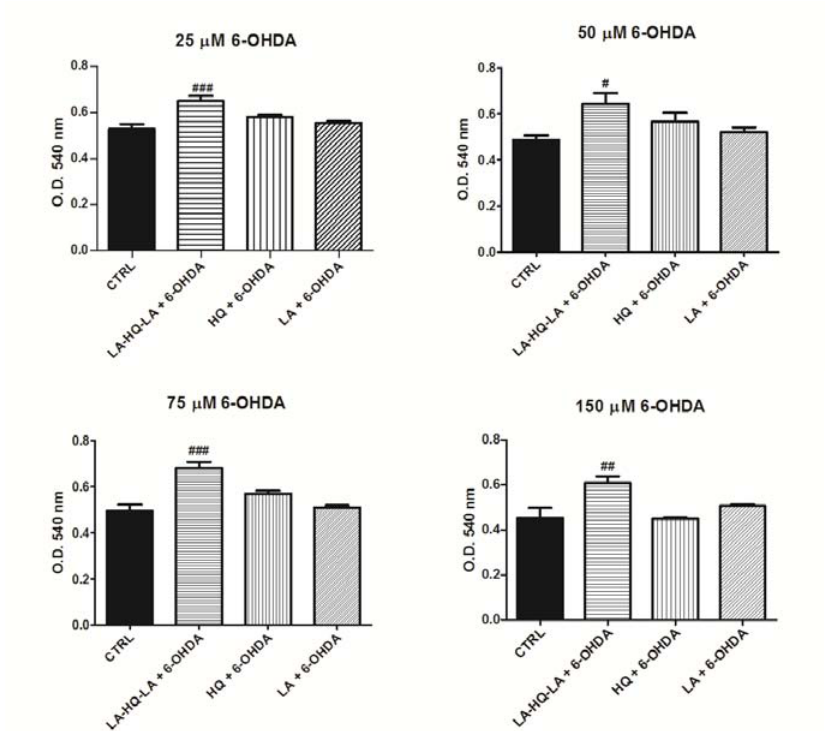
Figure 8. Neuroprotective effect of LA, HQ, and LA-HQ-LA in RA/PMA-differentiated and 6-OHDA-lesioned SH-SY5Y human neuroblastoma cells.